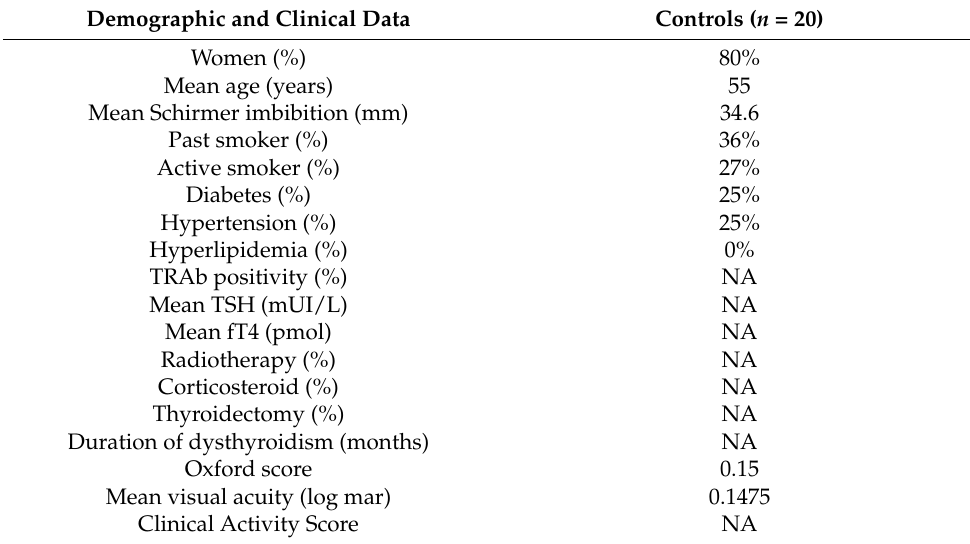
Table 3. Demographic and clinical status of individuals with dry eye of undetermined origin. Demographic and Clinical